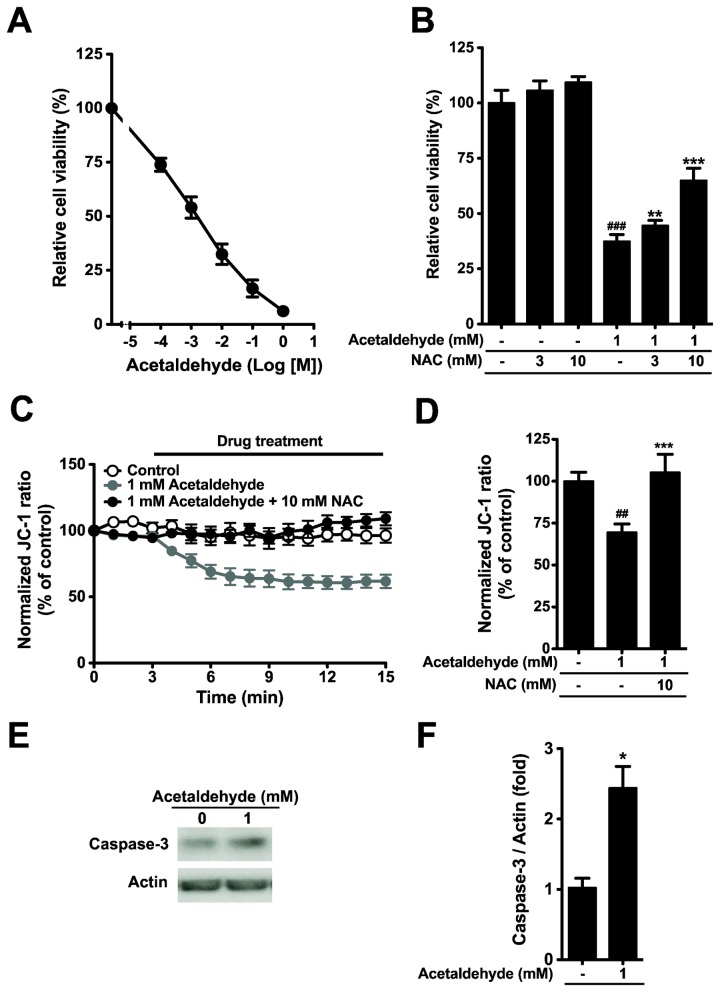
Acetaldehyde induces cell damage that is inhibited by NAC.(A) PDEC were treated with indicated concentrations of acetaldehyde for 4 h, and then cell viability was measured. (B) PDEC were treated with 1 mM acetaldehyde for 4 h with or without 30 min pretreatment of 3 or 10 mM NAC. n = 4 - 13 for each condition, ###
P < 0.001 compared to control. ** P < 0.01 and *** P < 0.001 compared to the cells treated acetaldehyde alone. (C and D) MMP measured with JC-1 dye. For the bar graph, MMP was evaluated as averages during drug treatments. n = 5 - 6 for each condition, ##
P < 0.01 compared to control and *** P < 0.001 compared to the cells treated with acetaldehyde alone. (E and F) Caspase-3 activation estimated with Western blot analysis. Cells treated with 1 mM acetaldehyde for 4 h were analyzed to detect activated caspase-3. For the summary bar graph, activated caspase-3 was calibrated by actin level of the samples and presented as relative to untreated control. n = 3 for each condition, *P < 0.05 compared to control.